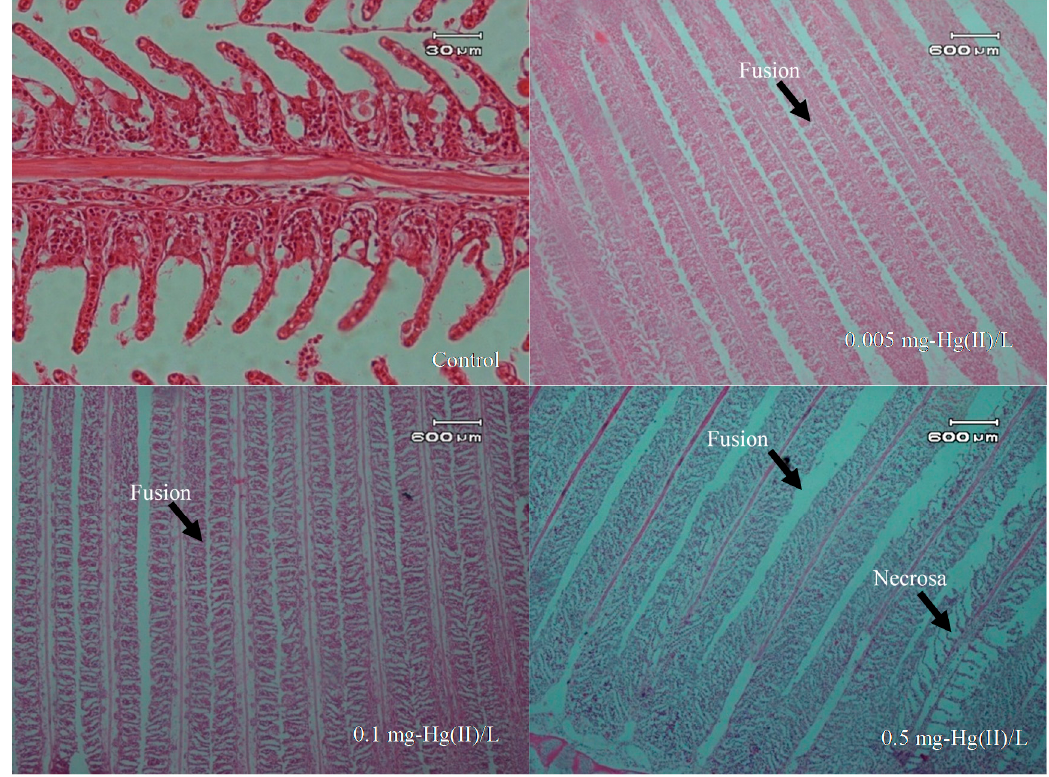
Figure 2. Pathological conditions of freshwater fish ( Oreochromis niloticus ) after exposure to Hg(II). ( A ) whitish body and eyes and ( B ) pale gills color.